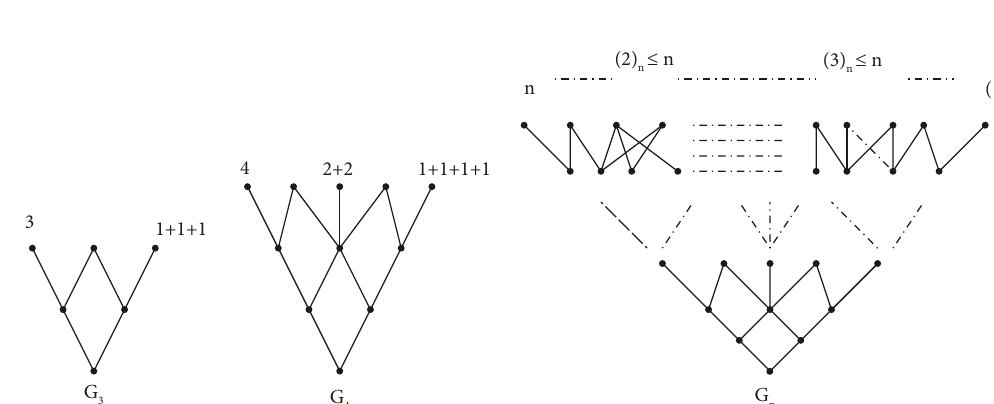
Figure 1: Integer-based graph for integer 5.